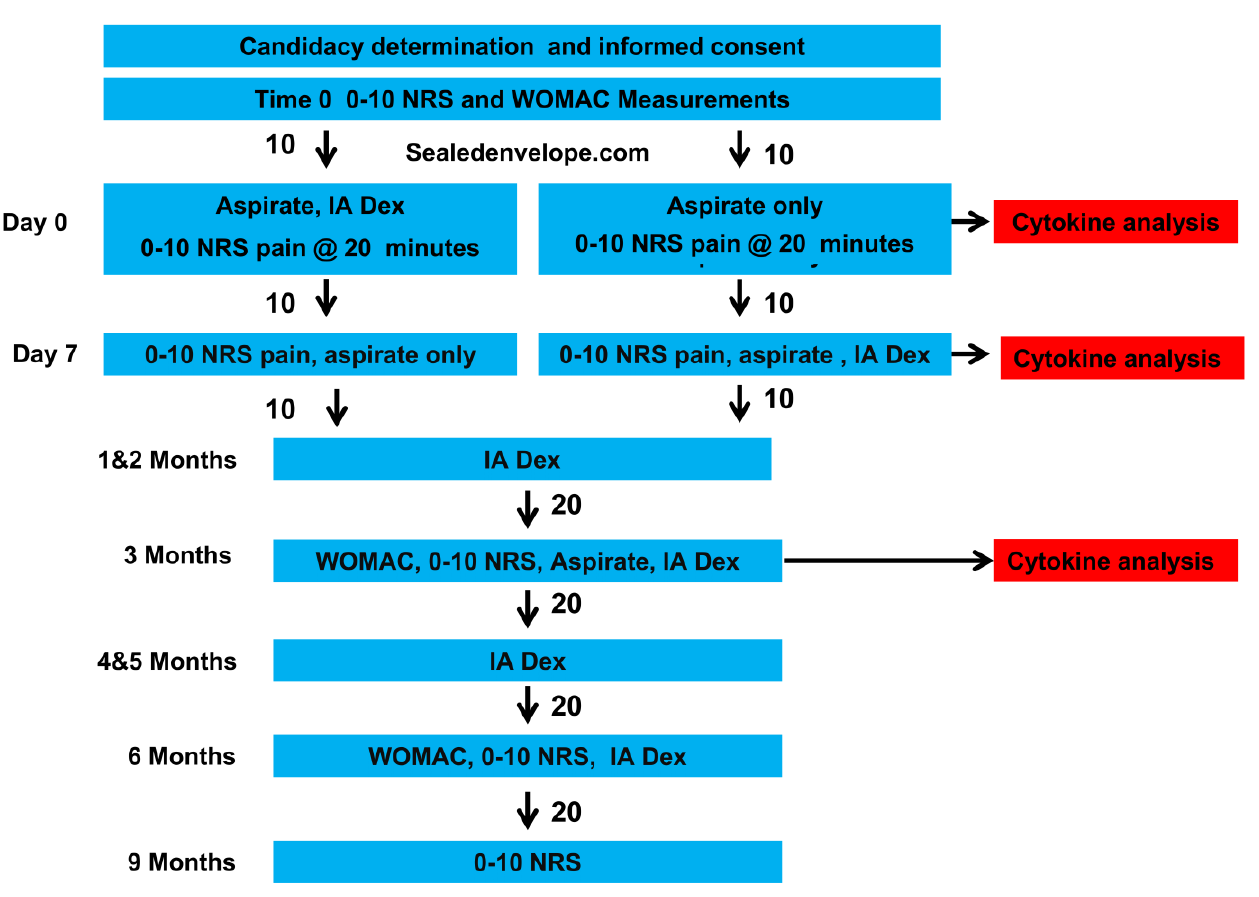
Figure 1. Consort flow chart.